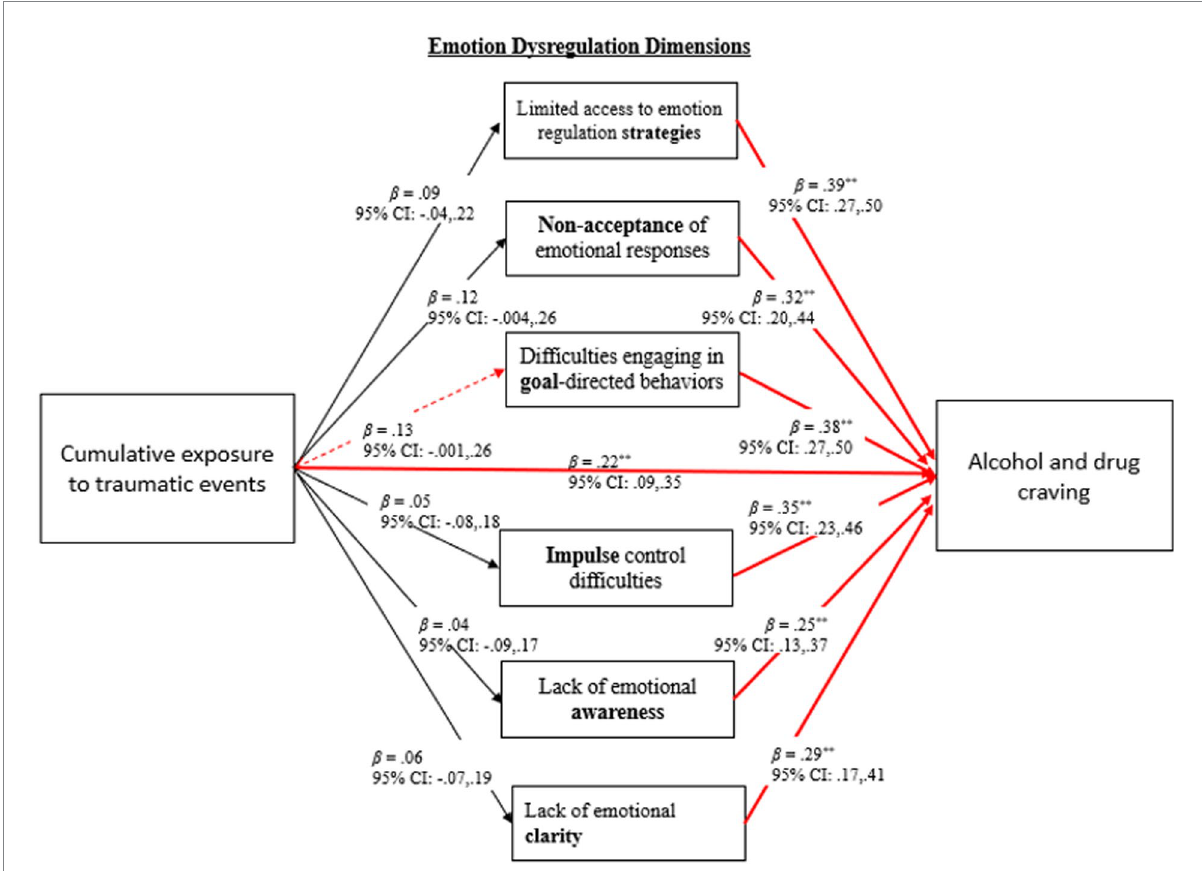
FIGURE 1 Results for direct and indirect associations between cumulative exposure to traumatic events, emotion dysregulation, and craving. * p < 0.05; * *p < 01; Dashed red line denotes marginal significance at p = 0.05; Models controlled for